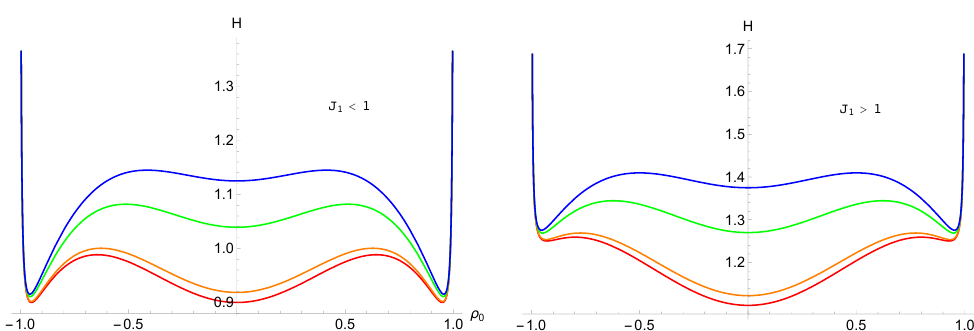
Figure 1 . Hamiltonian (2.12) as a function of the graviton’s size ρ 0 , for different values of the deformation ∆ . The left (right) plot is for values of J correspondence between color and values of ∆ for both plots of this figure is Red ⇒ ∆ = 0 , Orange ⇒ ∆ = 0 . 2 , Green ⇒ ∆ = 0 . 5 & Blue ⇒ ∆ = 0 . 6 . For both graphs when ∆ > 1 / graviton becomes a maximum and the potential acquires the shape of a Mexican-hat with the giant gravitons being the only minima. If we reinstate units the vertical axis is HL/N , the horizontal axis is ρ and the plots are for different values of J 0 /L